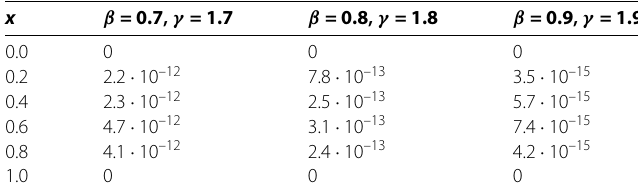
Table 7 Pointwise error of Example 5 for the case M = 14 at t =